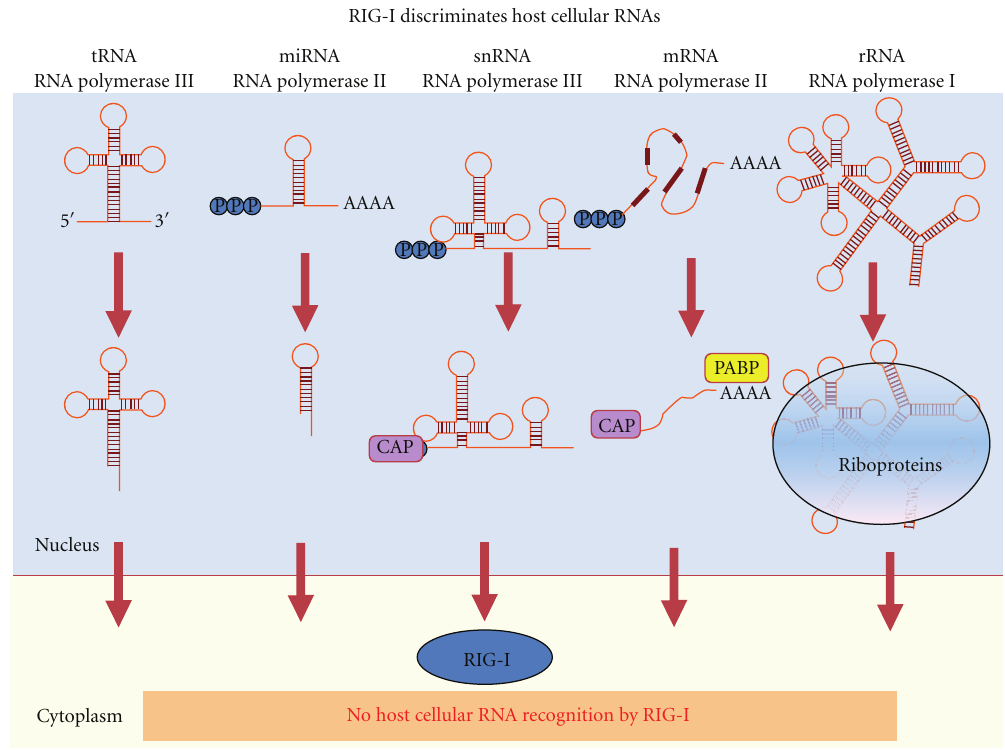
Figure 2: RIG-I discrimination of self and nonself RNA. The primary transcripts of cellular mRNA are produced in the nucleus and are modified before export to the cytoplasm; 5 (cid:2) ppp is replaced by a 5 (cid:2) cap structure on mRNAs while it is processed from tRNAs; microRNAs are processed to a length insu ffi cient for RLR recognition. Cellular RNA-binding proteins can prevent RIG-I detection of 5 (cid:2) -triphosphatae in rRNAs though masking as an RNP.